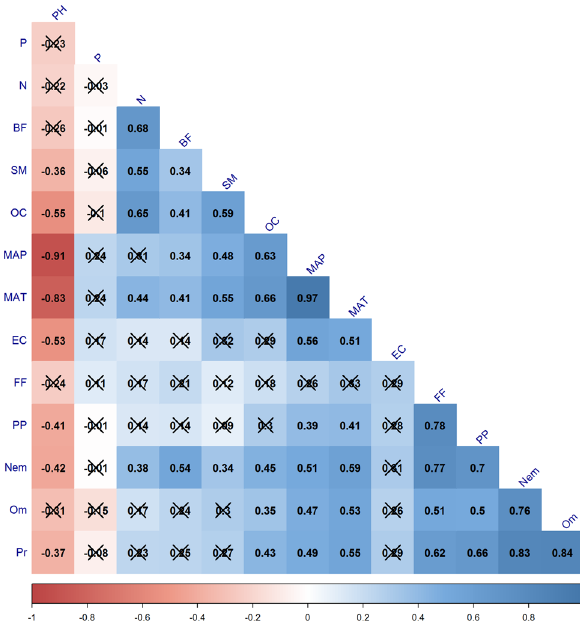
Figure 6. Association of Nematode trophic groups with soil physicochemical parameters. Correlation coefficients ( p < 0.05) of trophic groups and soil physicochemical parameters. (PH: Soil pH; EC: Electrical Conductivity (µS cm −1 ); OC: Organic Carbon; N: Nitrogen content; P: Phosphorous content; SM: Soil moisture; BF: Bacterivores; FF: Fungivores; Hr: Herbivores; Om—Omnivores; Pr—Predators; Nem—Total Nematode